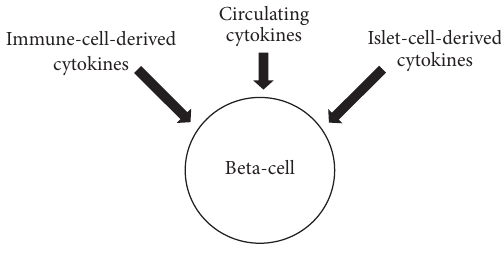
Figure 3: A basic depiction of the putative sources of cytokines affecting islets in